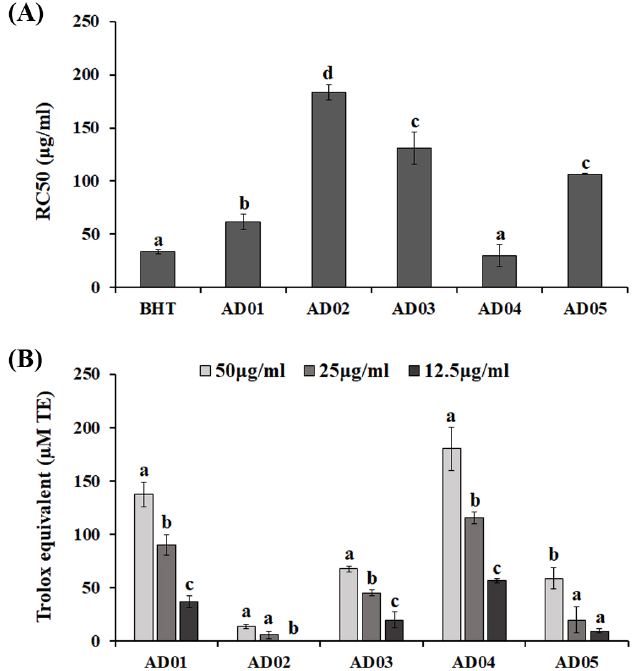
Fig. 1: Antioxidant activities of Abeliophyllum distichum extract. (A) DPPH radical scavenging activity of A. distichum methanol crude extract and its fractions. Bar graph showing the RC50 values for each extract from the DPPH assay. (B) ORAC values of A. distichum methanol crude extract and its fractions. Data are expressed as μM of Trolox (TE) equivalents. Data are expressed as the mean ± stan- dard deviation of three independent experiments. Values in the same column with different superscripted letters are significantly diffe- rent ( p < 0.05). MeOH extract; AD01, hexane fraction; AD02, ethyl acetate fraction; AD03, n-butanol fraction; AD04, aqueous fraction;